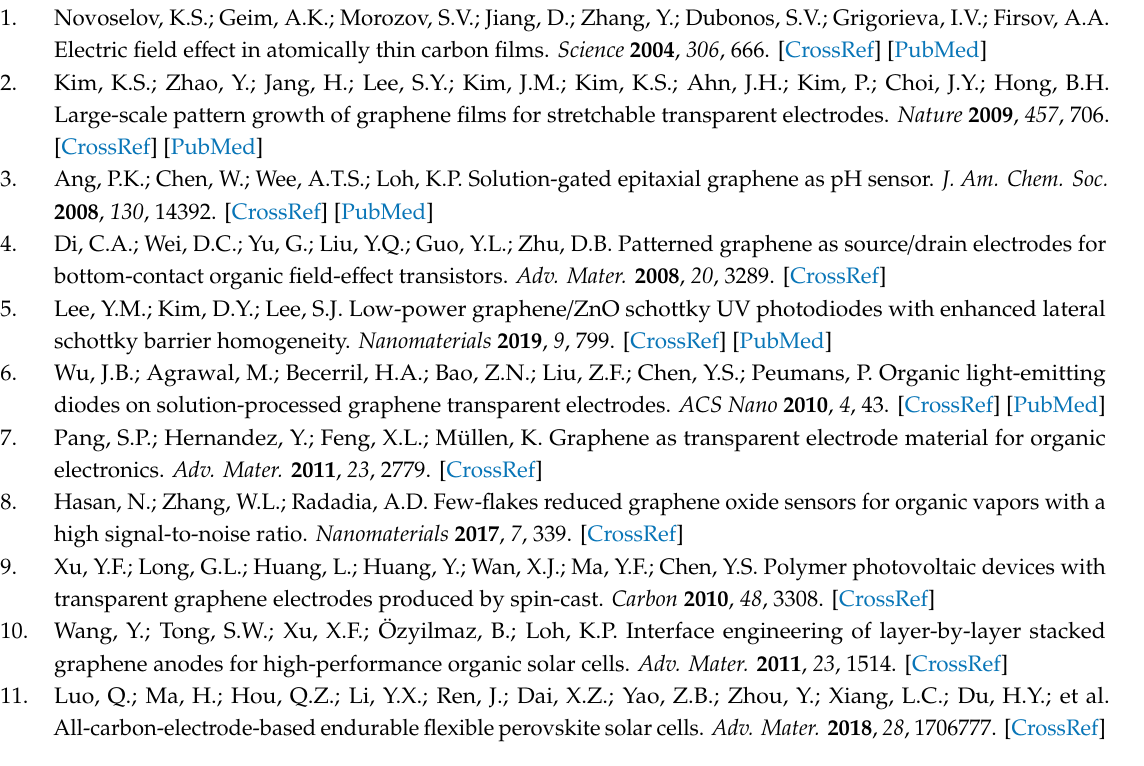
Figure S1: Molecular structures of NH 2 -SAM and F-SAM; Figure S2: Raman spectra for graphene on NH 2 -SAM, SiO 2 , and F-SAM; Figure S3: UPS spectra during the sequential deposition of 5.0 nm ZnPc on graphene; Figure S4: UPS spectra during the sequential deposition of 5.0 nm C 60 on